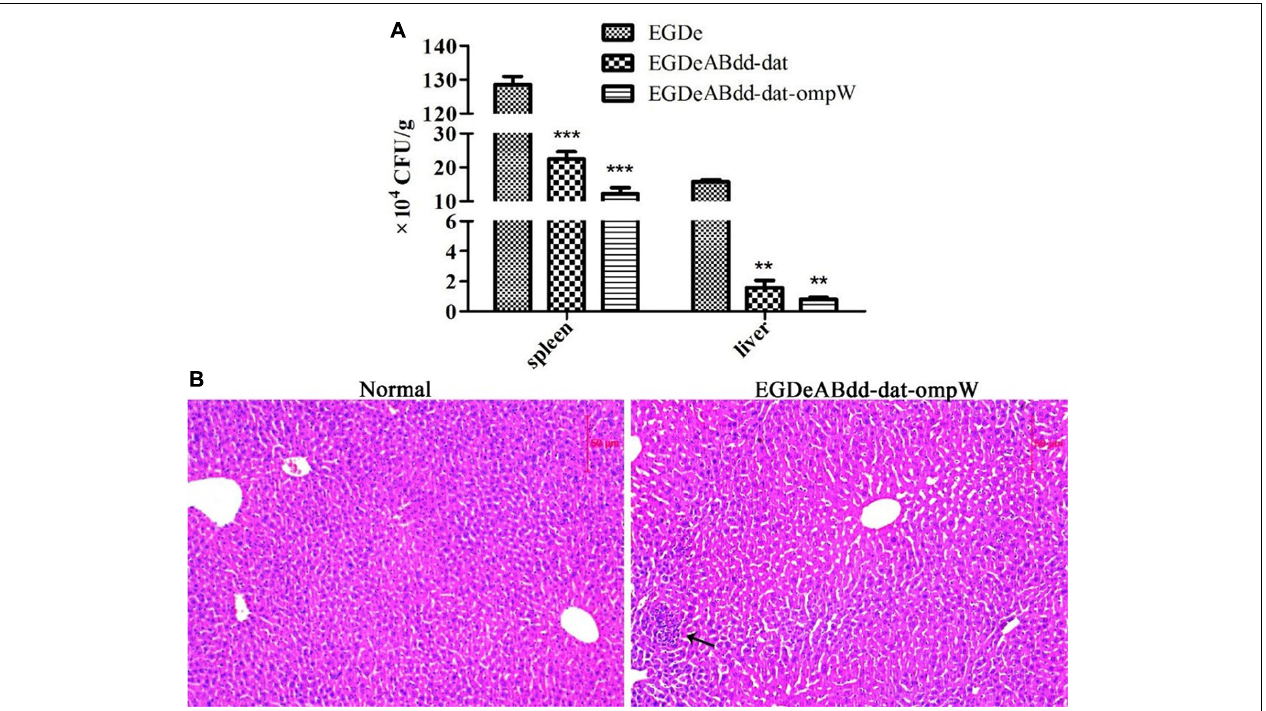
FIGURE 8 | Safety evaluation of vaccine strain to mice. (A) Organ distribution of EGDeABdd-dat and EGDeABdd-dat-ompW . Strains [2 × 10 7 colony-forming units (CFUs)] were intravenously administered to mice, and CFUs per gram in the spleen and liver were counted on the first day after injection. (B) Histological morphology of liver from mice immunized by EGDeABdd-dat-ompW . Immunized mice were sacrificed 3 days after intravenous injection of 5.0 × 10 7 CFUs EGDeABdd-dat-ompW . The liver was collected for H&E staining. Slight inflammatory responses were observed in some hepatocytes, and no tissue necrosis or structural damage was seen. ** P < 0.01; *** P <